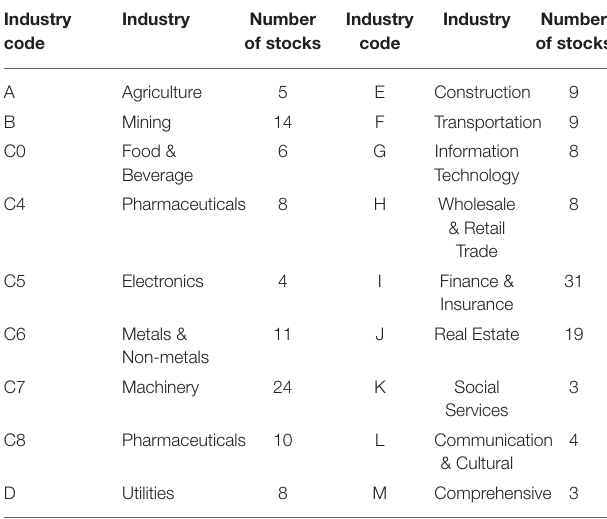
TABLE 4 | Industry information on constituent stocks in the SSE180